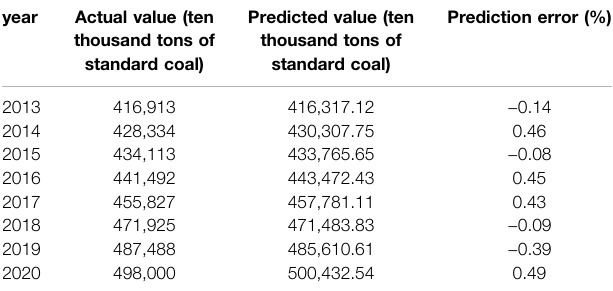
TABLE 3 | Prediction results of China ’ s energy consumption based on SVR